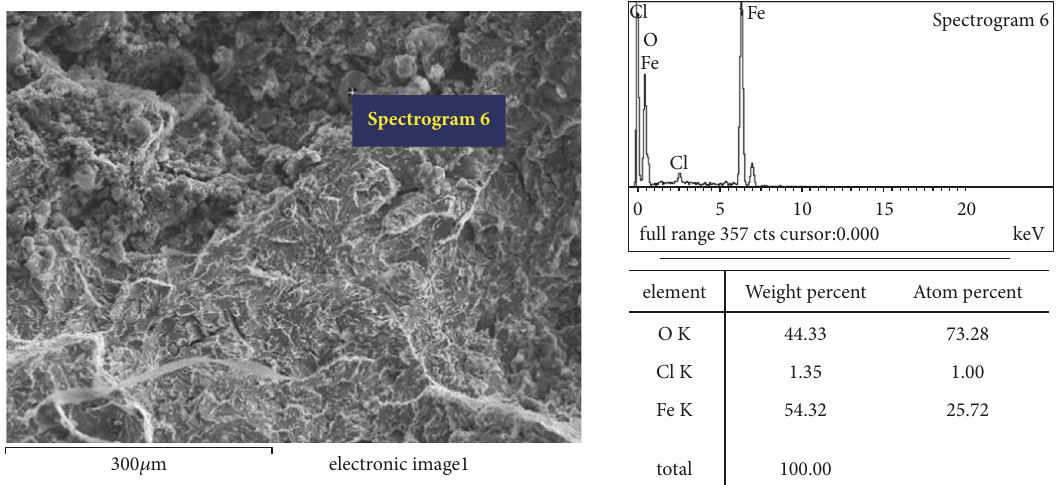
Figure 7: The oxides on the fracture of 4340 in 100 ∘ C oxygen-containing 0.1mol/L chloride aqueous